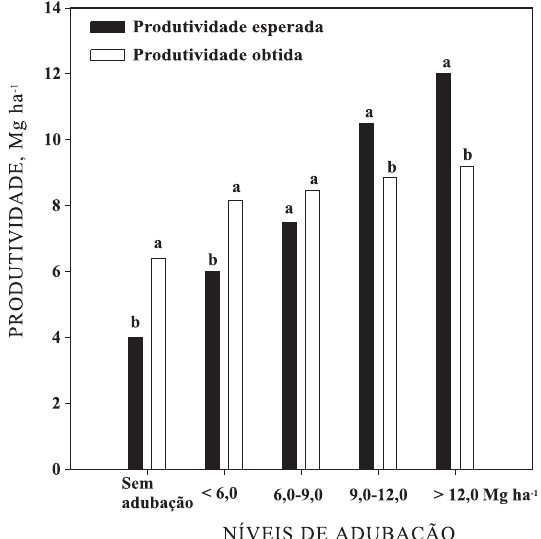
Figura 1. Produtividade de grãos de arroz irrigado esperada e obtida em função da adubação para diferentes expectativas de produtividade. Barras seguidas de mesma letra dentro de cada nível de adubação não diferem pelo teste de Tukey (p < 0,05). Média de 13 experimentos em diferentes cultivares, locais e safras (2004/2006).